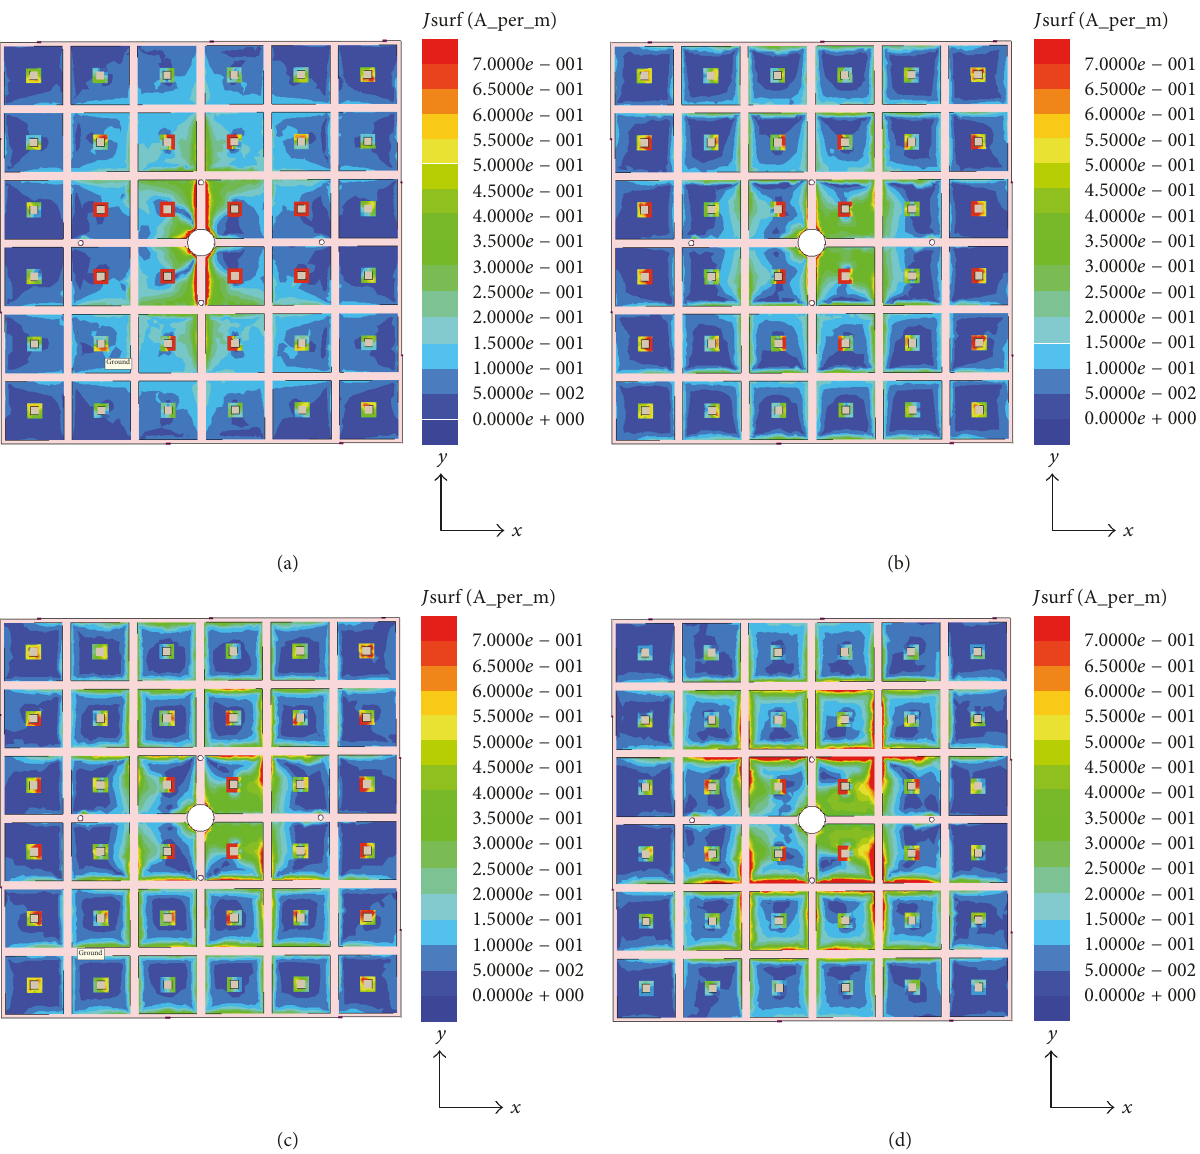
Figure 5: The simulated surface current distribution on 6 × 6 HIS array: (a) 0.55 GHz, (b) 0.60 GHz, (c) 0.65 GHz, and (d) 0.70